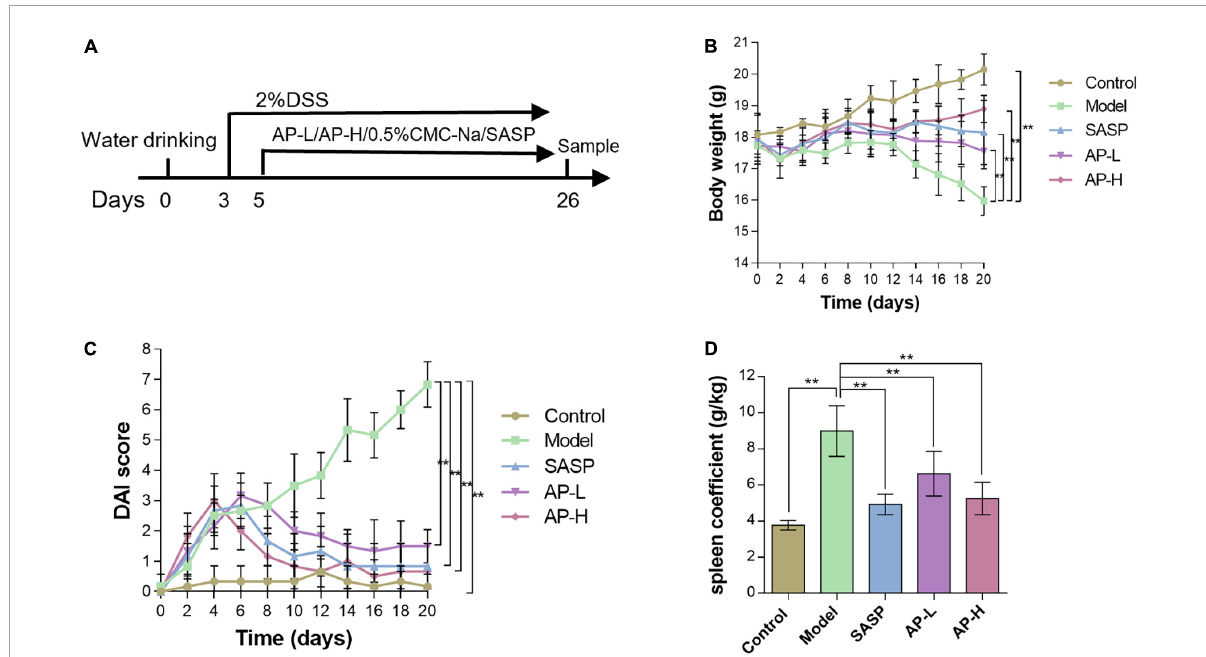
FIGURE1 Apigenin protected experimental UC in mice. (A) A schematic of the UC and apigenin (AP) treatment design. (B) Changes in body weights (g) of mice. (C) Disease activity index (DAI) scores for weight loss and fecal status in each group. (D) Spleen coefficient of each treatment group. ** P <